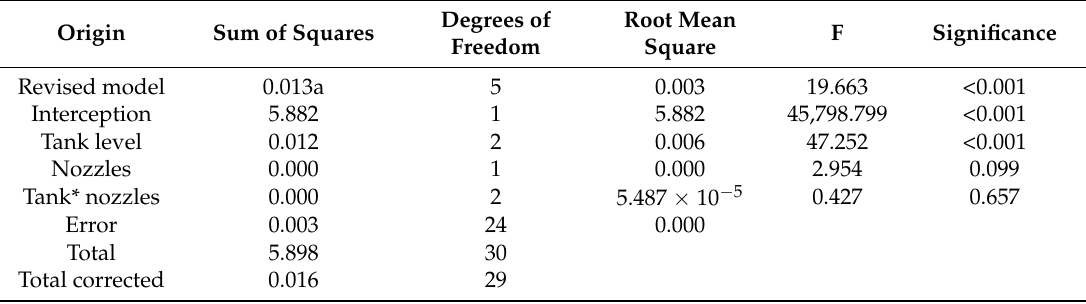
Table 6. Univariate general linear model of the concentration of copper oxychloride according to the level of water into the tank (1000, 2000, 3000 L) and the number of nozzles (2, 4).